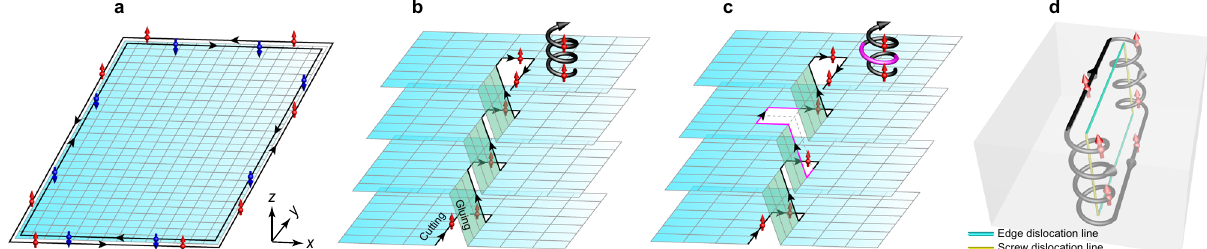
Fig. 1 TDMs guided by the dislocations in a 3D TI. a Sketch of 2D QSH effect, featuring one pair of spin-locked edge modes at the boundaries of a fi nite QSH insulator. The red and blue arrows denote the spin-up and spin-down modes, respectively, and the black arrows indicate their propagating directions. b A TDM running spirally along the screw dislocation line in a layer-stacked 3D TI, as visualized vividly with the bold spiral arrow. For brevity, in b – d we only sketch the spin-up mode and omit its time-reversal counterpart. c Scattering-immunity of the TDM to a spin-preserved defect (highlighted with magenta). d Unidirectional propagation of the spin-locked TDM in a dislocation loop connected with edge and screw dislocations.